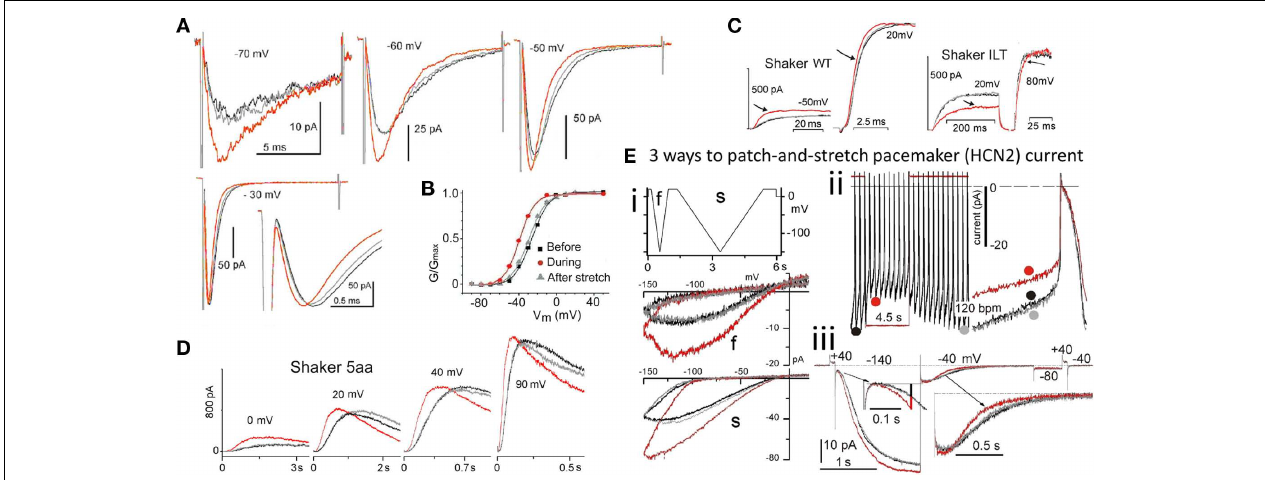
Reference Laitko et al., 2006). (D) In Shaker 5aa, voltage-dependent FIGURE 3 |VGC operation is inherently mechanosensitive (MS). (A) gating is two orders of magnitude slower than in Shaker (compare to C; Nav1.5 channel current accelerates reversibly with stretch; activation and note the different time scales), but since an independent (though sluggish) inactivation rates both speed to the same extent (Gmax has been reached at − 30mV in this patch, so peak I voltage-dependent transition is rate-limiting for activation, this mutant Na is unaffected by stretch, but activation and channel behaves like its “WT” counterpart (see Laitko and Morris, 2004). fast inactivation both reversibly accelerate; modified from Morris and Juranka, (E) HCN2 channels open with hyperpolarization, they close with 2007a). (B) a Nav1.5 activation Boltzmann left-shifts reversibly with stretch. depolarization, they have multiple open states and they exhibit pronounced (C) Shaker (Kv1) and Shaker-ILT have different rate-limiting voltage transitions hysteresis. Here HCN2 currents are studied by (i) ramp clamp, (ii) passive in the activation pathway. Stretch affects both, but it accelerates the (largely action potential clamp and (iii) classic step clamp (see Lin et al., 2007) for independent) movement of the Shaker voltage sensors, whereas it details. Upon a step depolarization (iii) from − 140 to − 40mV, stretch decelerates (the late concerted) movement of the voltage sensor in accelerates channel closure. Gating currents show this transition to be Shaker-ILT, as seen here for voltages near the foot and head of the respective analogous to the rate-limiting depolarization-induced “outward” voltage G(V)s; in keeping with the acceleration vs deceleration, stretch left-shifts the sensor motion in Kv Shaker Boltzmann and right-shifts the Shaker-ILT Boltzmann (not shown; see